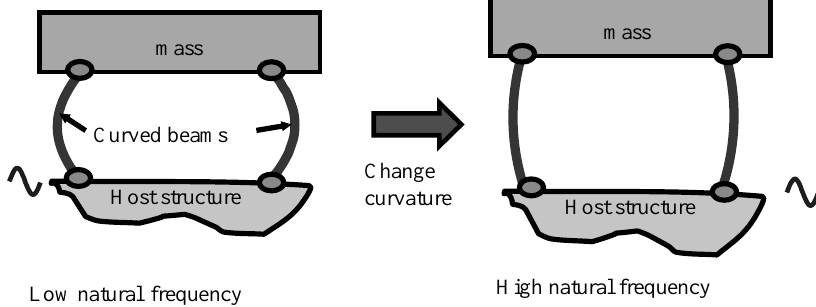
Fig. 3. ATVA with stiffness element formed from parallel curved beams. As the beams straighten, the natural frequency increases.